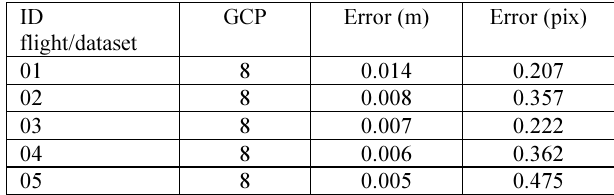
Table 6: Residual error of GCPs estimated positions by PhotoScan